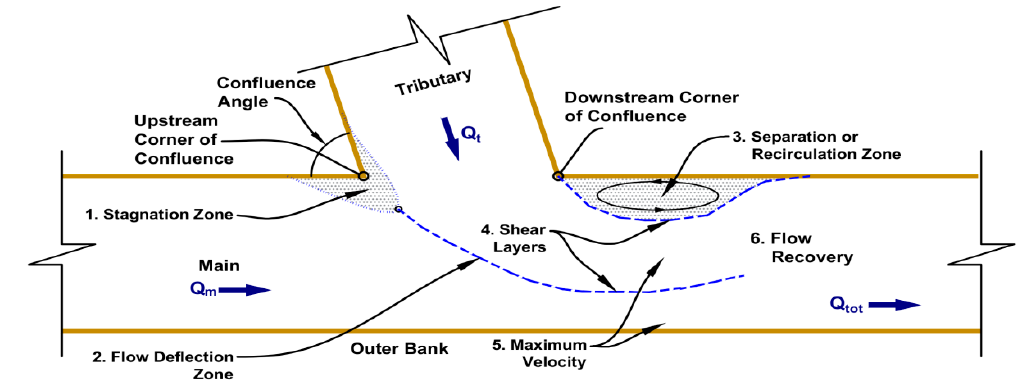
Figure 5. Six identifiable flow zones at a confluence—adapted from Best [32] .